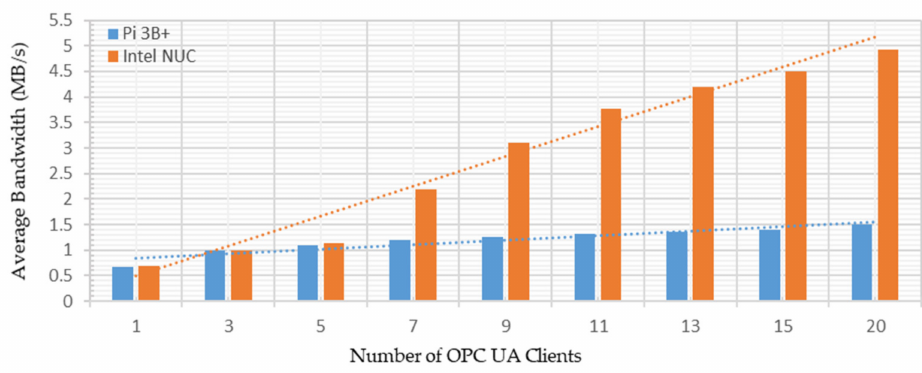
Figure 18. Average bandwidth utilization with varying the connected OPC UA clients. From Figure 18, averages of 0.6996 MB/s and 0.6662 MB/s bandwidth